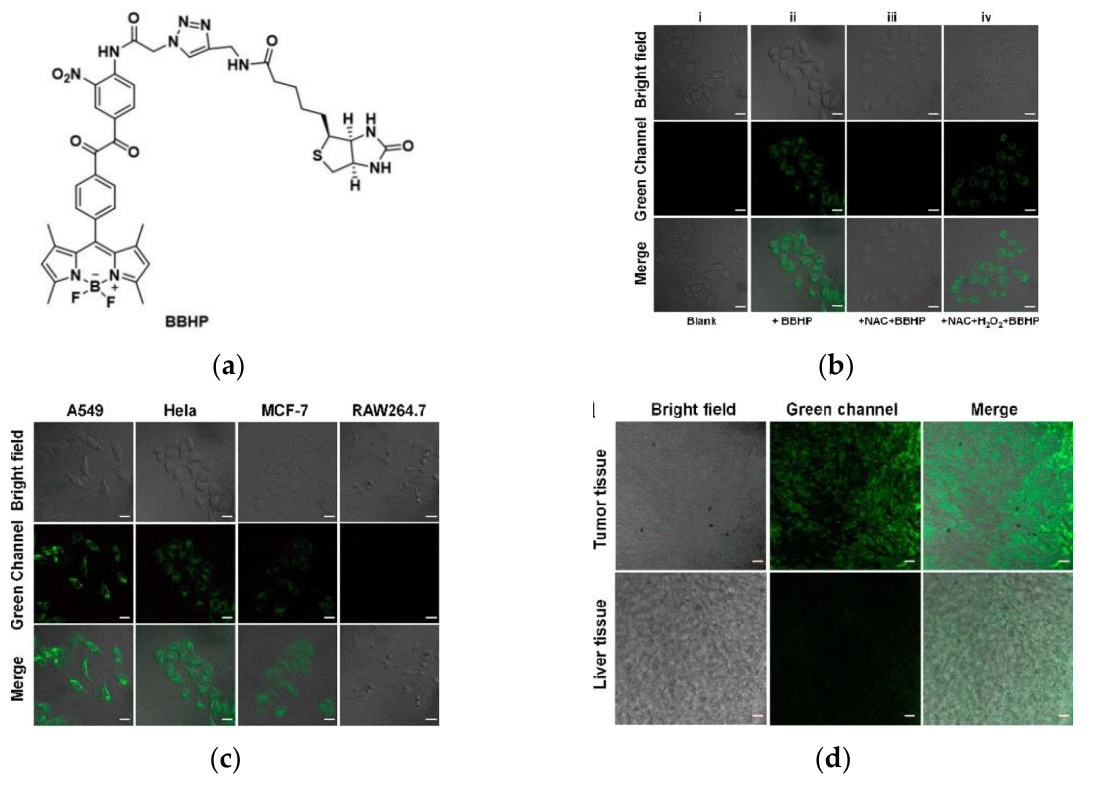
Figure 33. ( a ) Structure of BBHP; ( b ) Fluorescence imaging in HeLa cells; ( c ) Fluorescence imaging in different cancer cells; ( d ) Fluorescence imaging in normal and tumor tissues. Reproduced with permission from [139]. Copyright 2022 American Chemical Society.